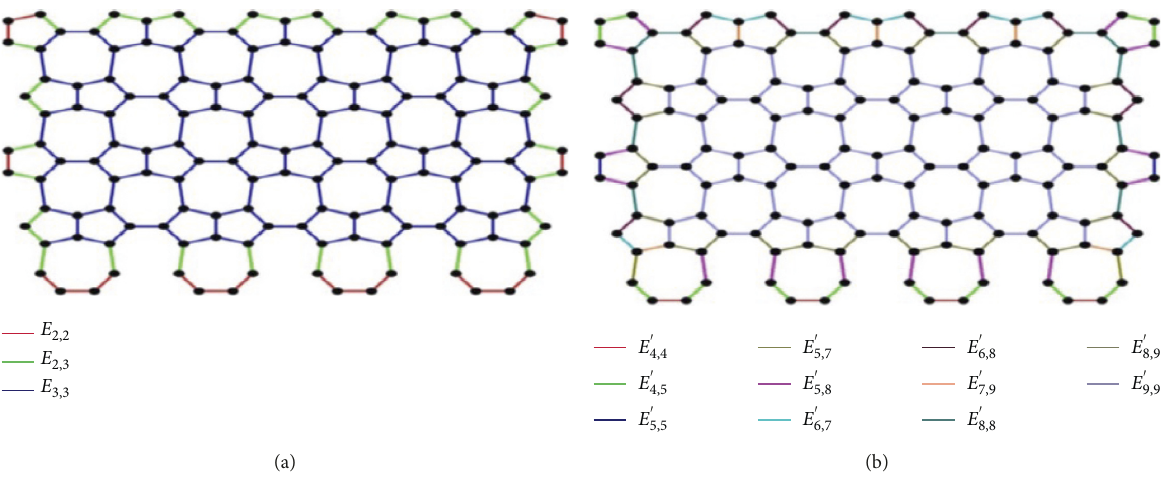
Figure 4: The edge partition of the nanosheets (a) HC